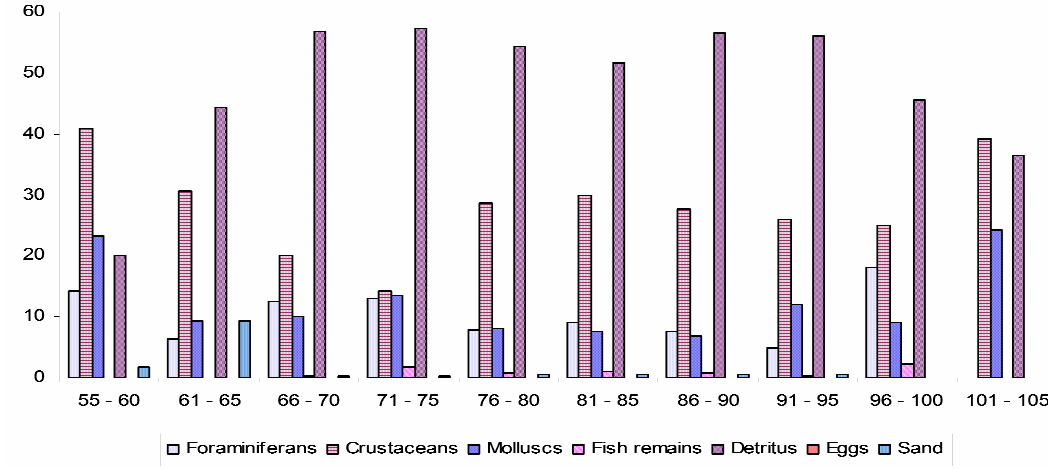
Fig. 5. Diet composition in different size-groups of males of S.